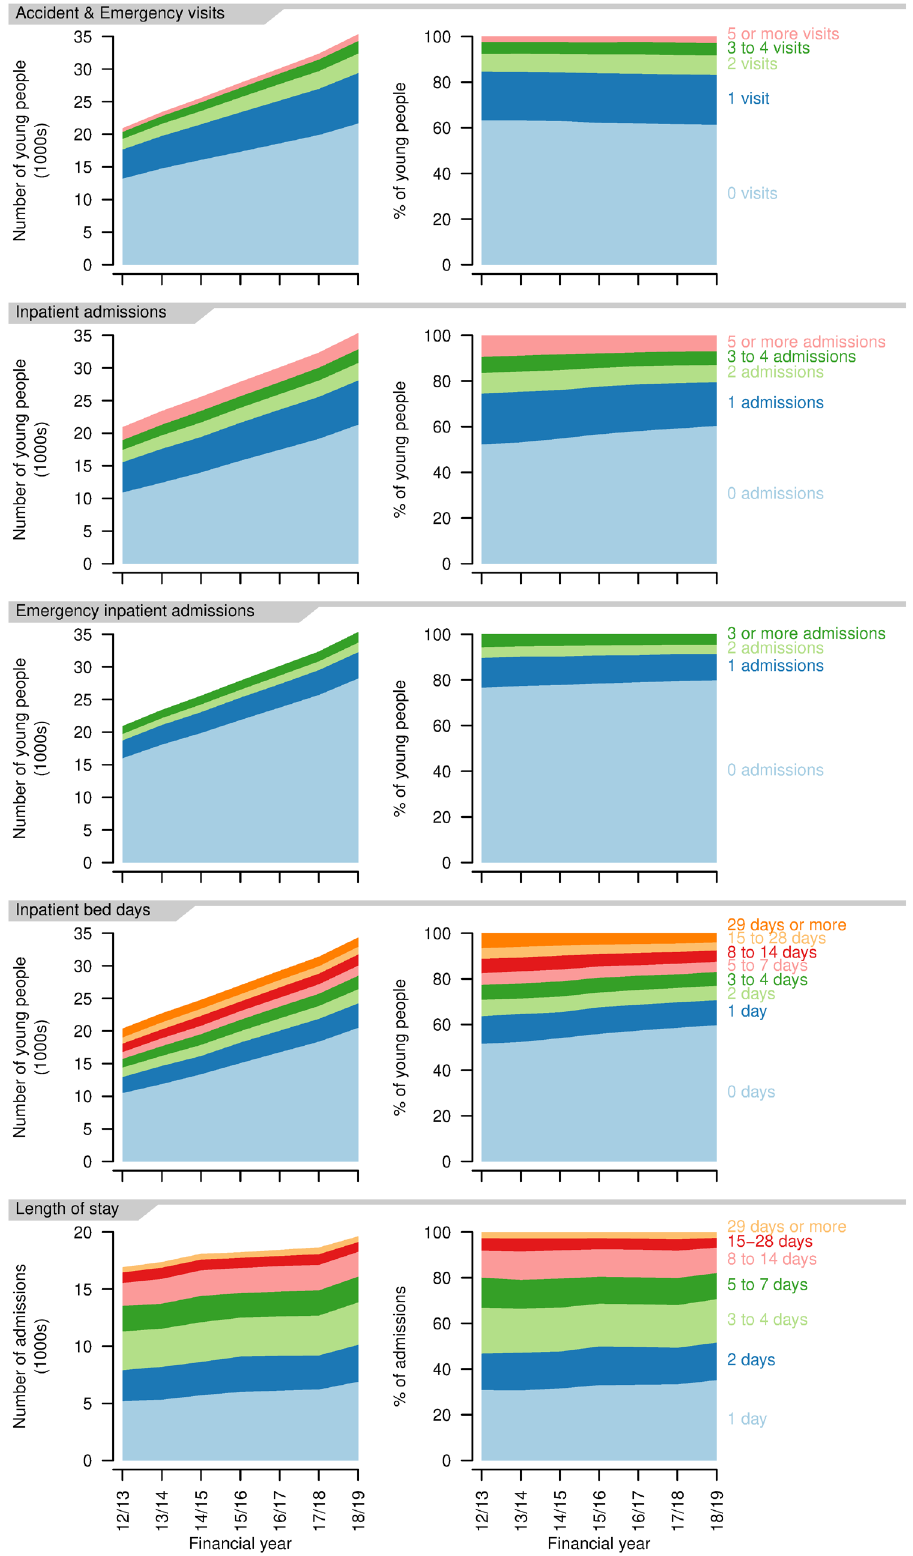
Figure 8. Indicators of high resource use for young people aged 14–19 years with a life-limiting condition. First four rows: numbers (left) and proportions (right) of young people having different numbers of Accident & Emergency visits, inpatient admissions, emergency inpatient admissions, bed days in each year. Final row: numbers (left) and proportions (right) of inpatient admissions of differing lengths in each